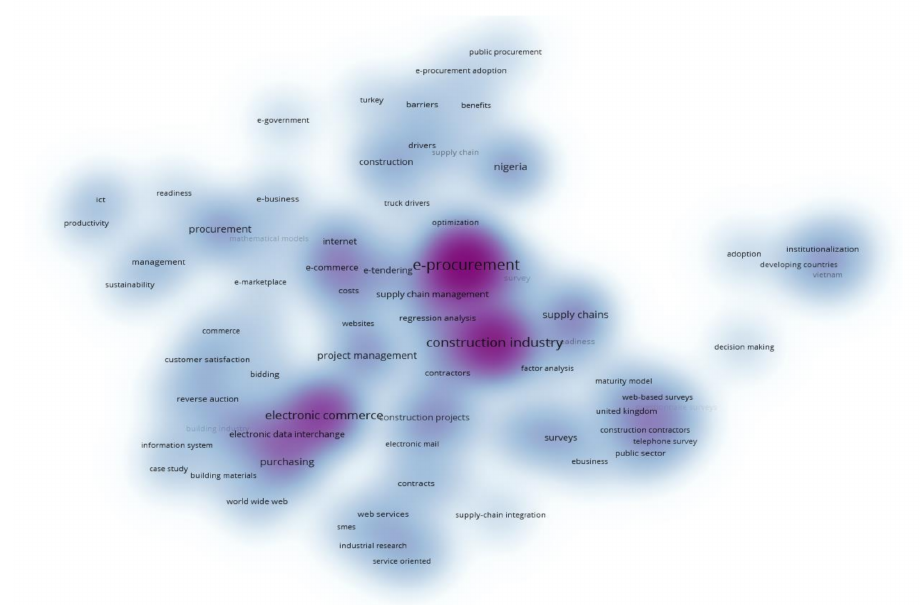
Figure 4. Heatmap illustration of the keyword burst; Source: authors’ field data. Note: Please, zoom in for higher resolution and better view.